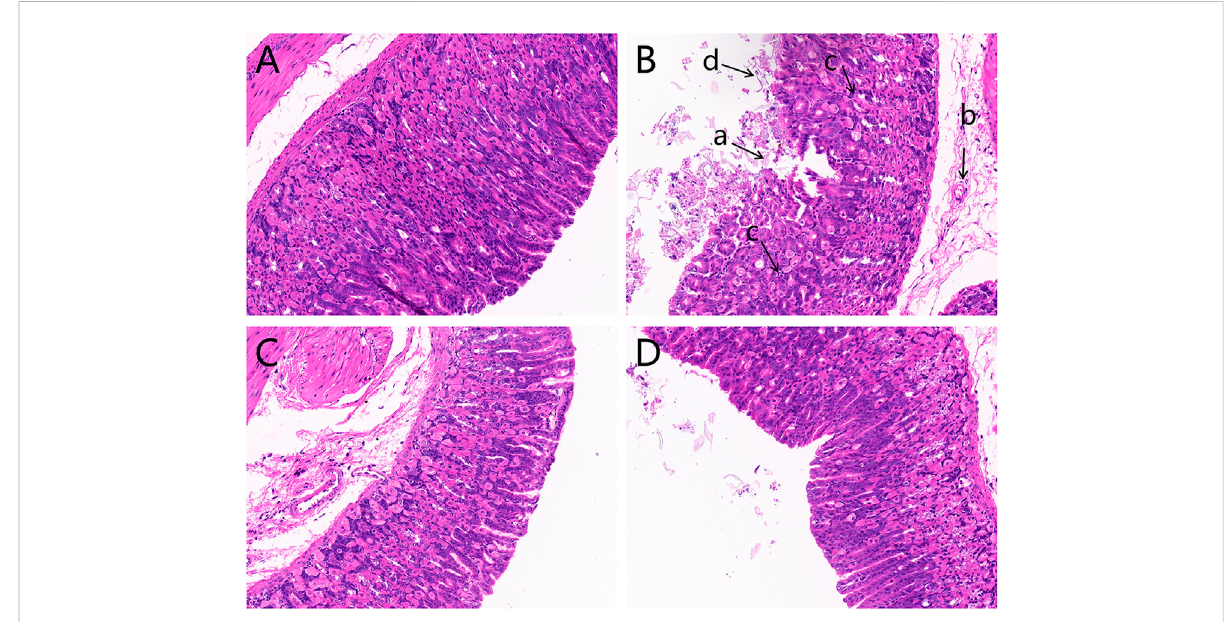
FIGURE 1 Histologicalimagesofhematoxylinandeosin-stainedgastricmucosa(magni fi cation×200). (A) Controlgroup; (B) Modelgroup; (C) OPZgroup; (D) DF group. (a) Epithelial cell loss; (b) in fl ammatory cell in fi ltration; (c) disorganized glandular structures; (d) gastric mucosal